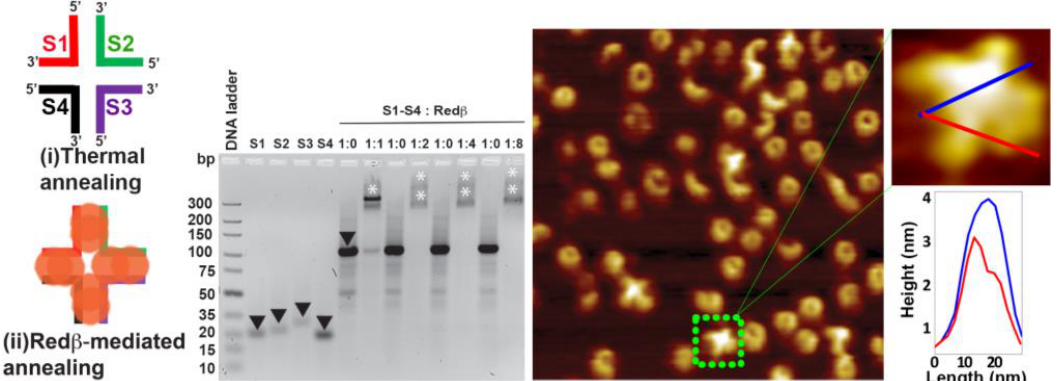
Figure 2. The schematic structures show the 44 mer HJ junction design assembled by thermal ( i ) and Redβ-mediated ( ii ) annealing. The sodium borate agarose gel analysis shows the saturation concentration ratio of Redβ to ssDNA. The downward-facing arrowheads (black) in lanes S1, S2, S3, and S4 of the gel image indicate the free ssDNA, while the asterisks indicate the HJ structures. The black downward-facing arrowhead in the first lane 1:0 indicates self-annealed HJ structures without protein. Note that the apparent differences in HJ band intensity for the different ssDNA/Redβ ratios are not due to any loss of DNA but rather due to a smearing of the bands (indicated by further asterisks), which results from the formation of a variety of different DNA–protein complexes. The AFM image depicts the resulting Redβ-mediated HJ assemblies. The height profiles were taken along the lines indicated in the zoom. The AFM image has a size of 300 × 300 nm² and a height scale of 4 nm.